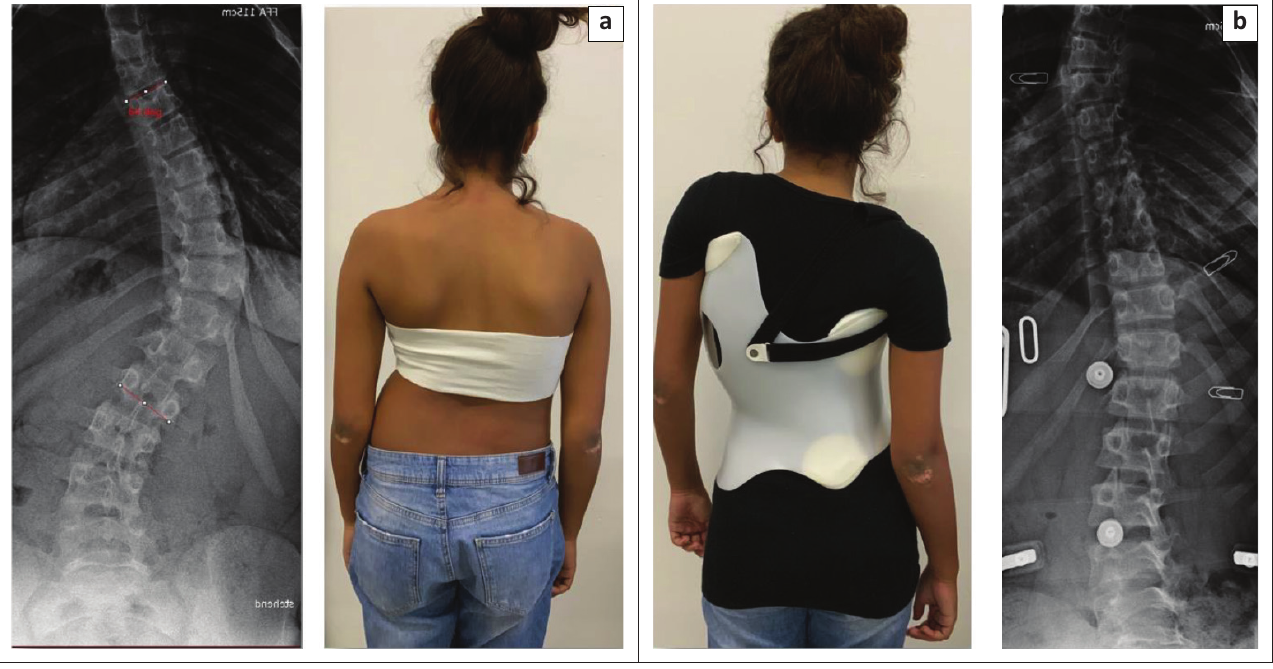
FIGURE 3: (a) Patient with a severe curve exceeding 60° Cobb angle without the brace and (b) in the special high correction Chêneau style brace (Gensingen brace) for curves exceeding